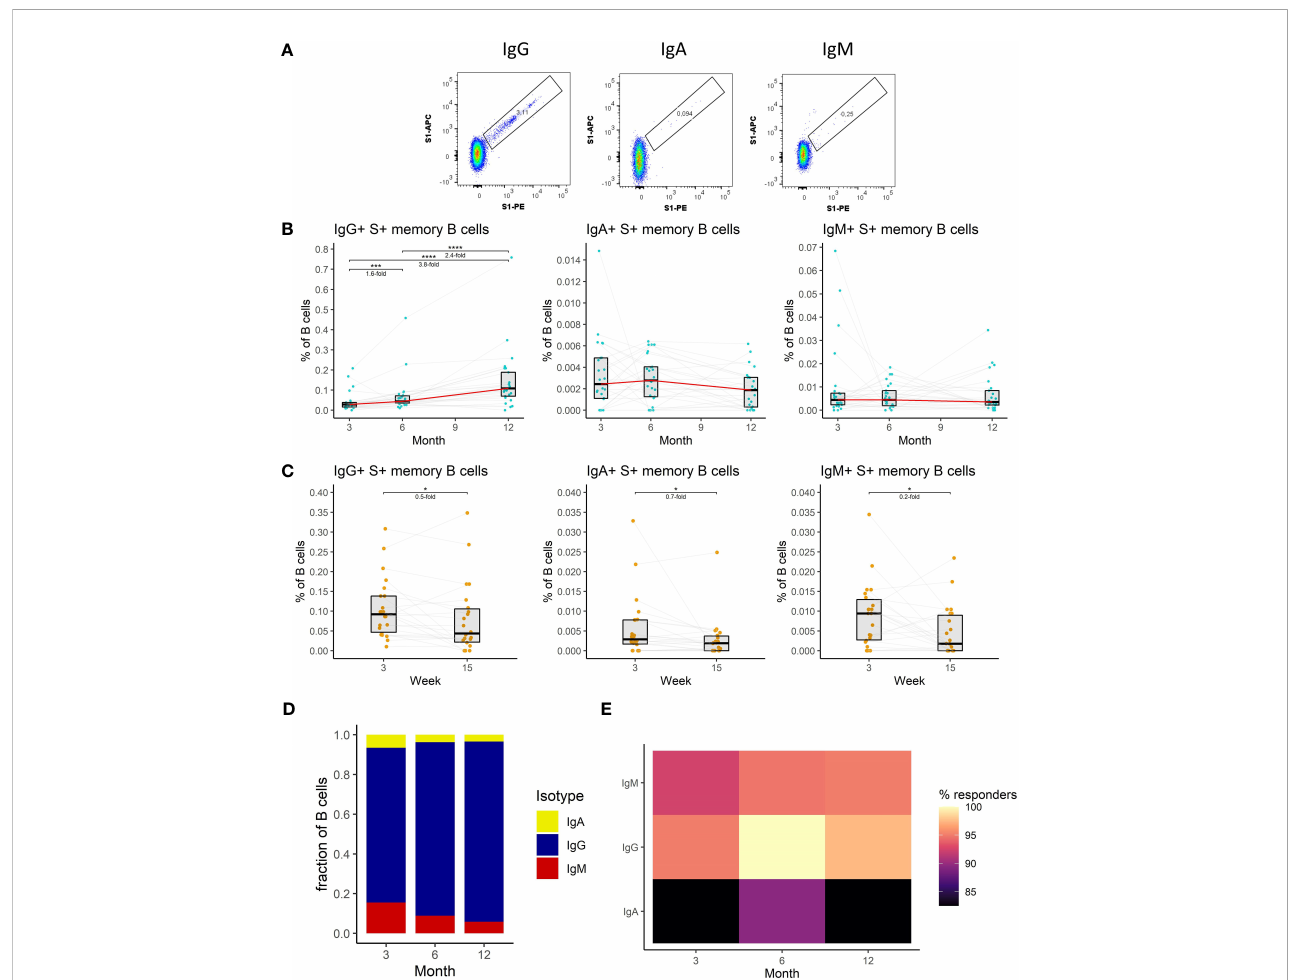
FIGURE 3 The dynamics of SARS-CoV-2-speci fi c memory B cell response after the initial and booster doses of mRNA vaccine. (A) Representative fl ow cytometry plots for identi fi cation of S1-speci fi c memory B cells with different BCRs. (B) Frequencies of IgG+, IgA+, and IgM+ S1-speci fi c memory B cells as a percentage of total B cells in the peripheral blood of vaccinated individuals for months 3, 6, and 12 after the initial vaccination. The red line connects the median values of each time point. Fold change was calculated as a ratio of the medians of compared time points. (C) Frequencies of IgG+, IgA+, and IgM + S1-speci fi c memory B cells in peripheral blood of vaccinated individuals 3 to 15 weeks after the booster vaccination. (D) Relative proportions of S1- speci fi c memory B cells bearing BCRs of a different isotype. (E) Percentage of individuals with detectable S1-speci fi c memory B cells according to the BCR isotype and time point. Differences between the groups were assessed using the Wilcoxon test with Holm ’ s correction for multiple